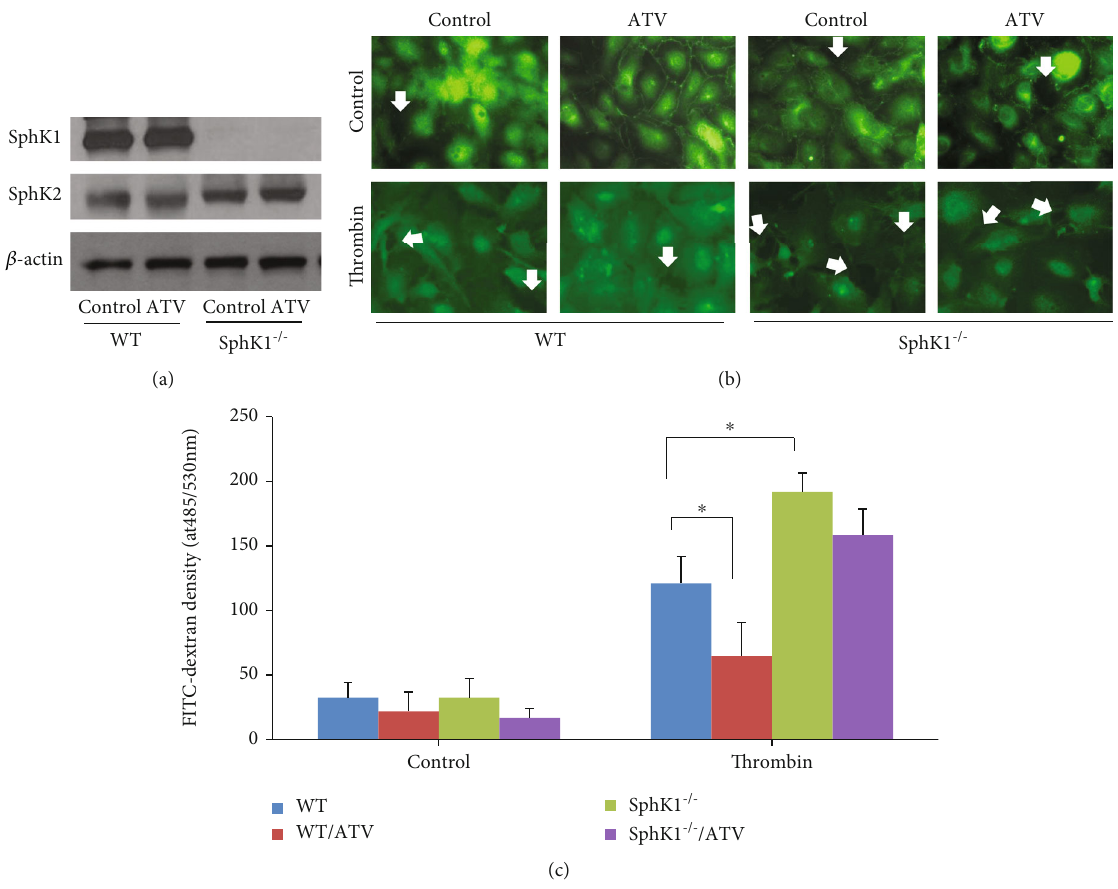
Figure 7: Atorvastatin did not change SphK1 expression in mouse EC but enhance EC junction integrity. (a) The ECs isolated from WT and SphK1 -/- mice were cultured in 6-well plates. The protein levels of SphK1 and SphK2 were determined by western blotting. (b) The ECs isolated from WT or SphK1 -/- mice were cultured on glass slides in a 12-well plate. After treatment with 10 μ M atorvastatin for 16 hours, the cells were challenged by 1U/ml thrombin for 1 hour. Immunostaining was performed with VE-cadherin antibody as described in Materials and Methods. (c) Monolayer endothelial cells were cultured on transwell inserts and treated with 10 μ M atorvastatin for 16 hours. The next day, the cells were treated with 1 U/ml thrombin for 1 hour in the presence of FITC-dextran. The FITC-dextran fl uorescent density in the bottom chamber was measured at 485/538 nm ( ∗ P < 0 : 05